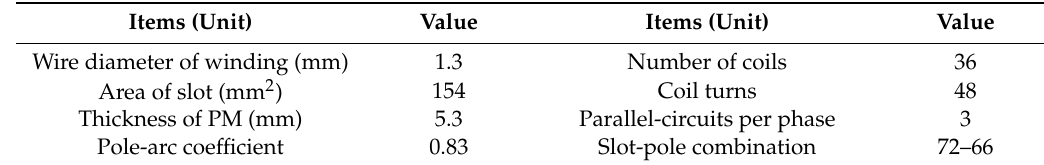
Table 1. The main parameters of the DDPMSM.